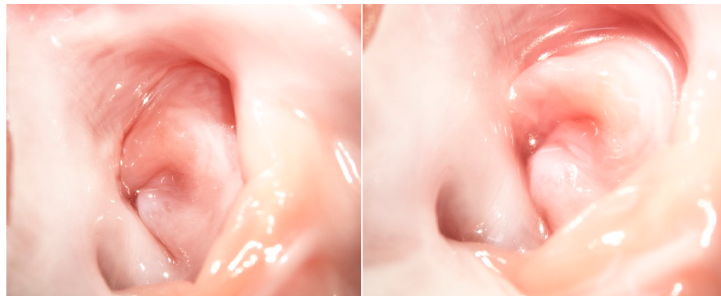
Figure 6. Fossa ovalis imaged using microscope (Nikon, SMZ1270) at a scale of 500